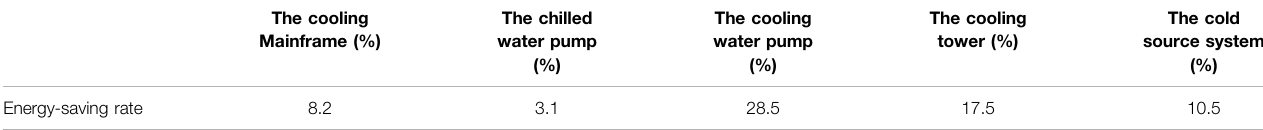
TABLE 3 | Central air conditioning system components energy-saving